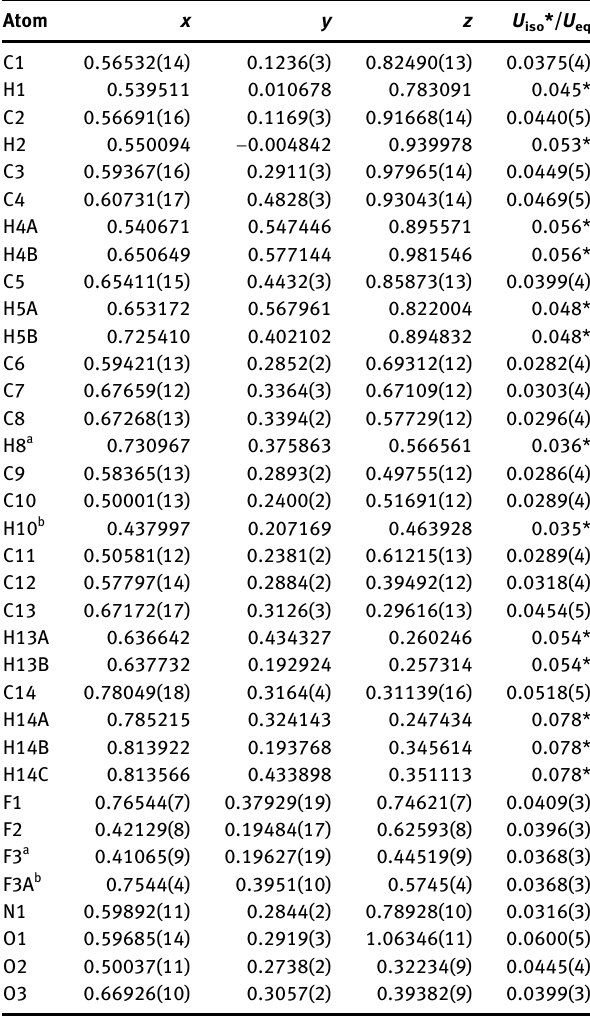
Table  : Fractional atomic coordinates and isotropic or equivalent isotropic displacement parameters (Å 